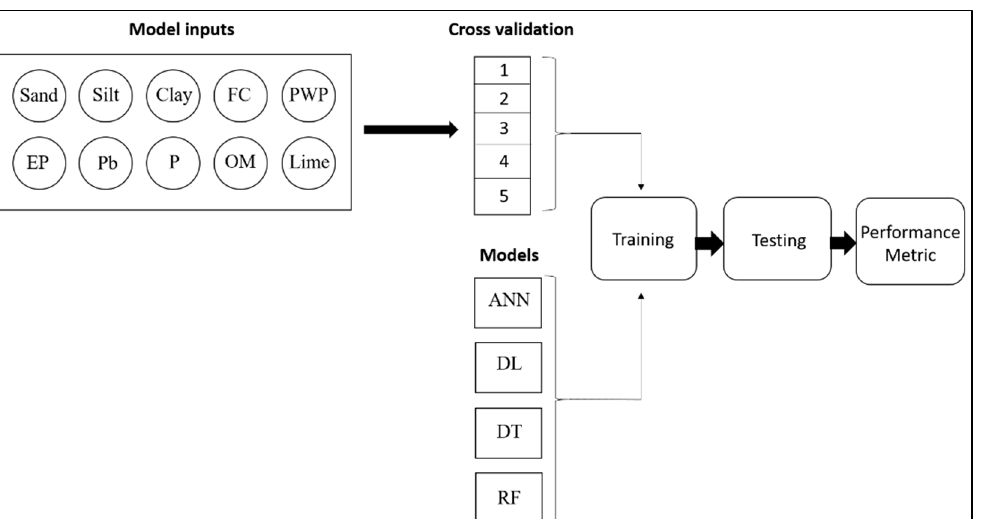
Figure 3. The flowchart of machine learning models for estimation of Ks.